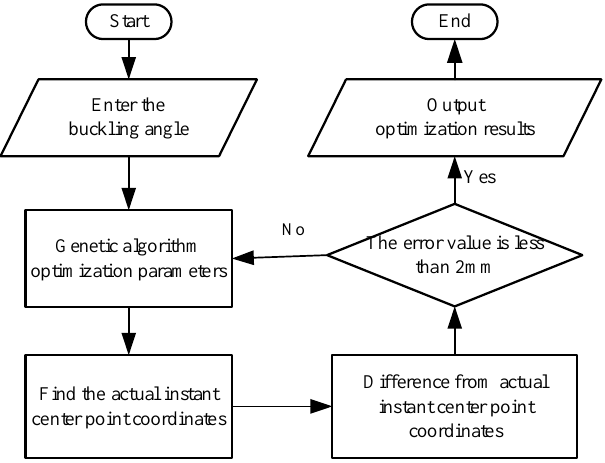
Figure 11. Optimization flowchart.